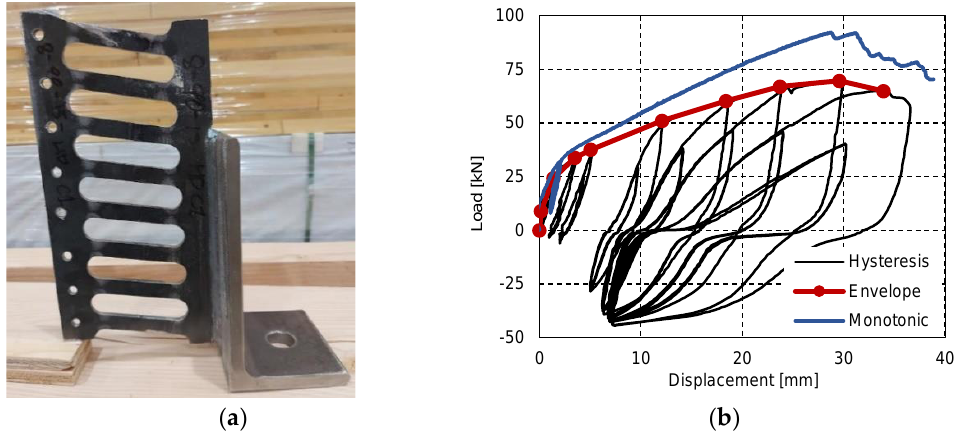
Figure 12. ( a ) Deformed HD with IBSP (photo credit: Thomas Tannert); ( b ) force – displacement curves.